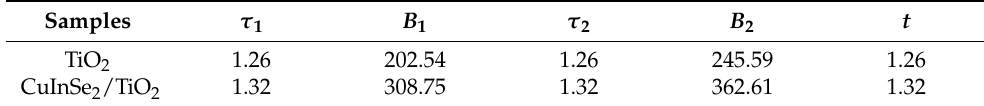
Table 1. Fitting results from Figure 5d.